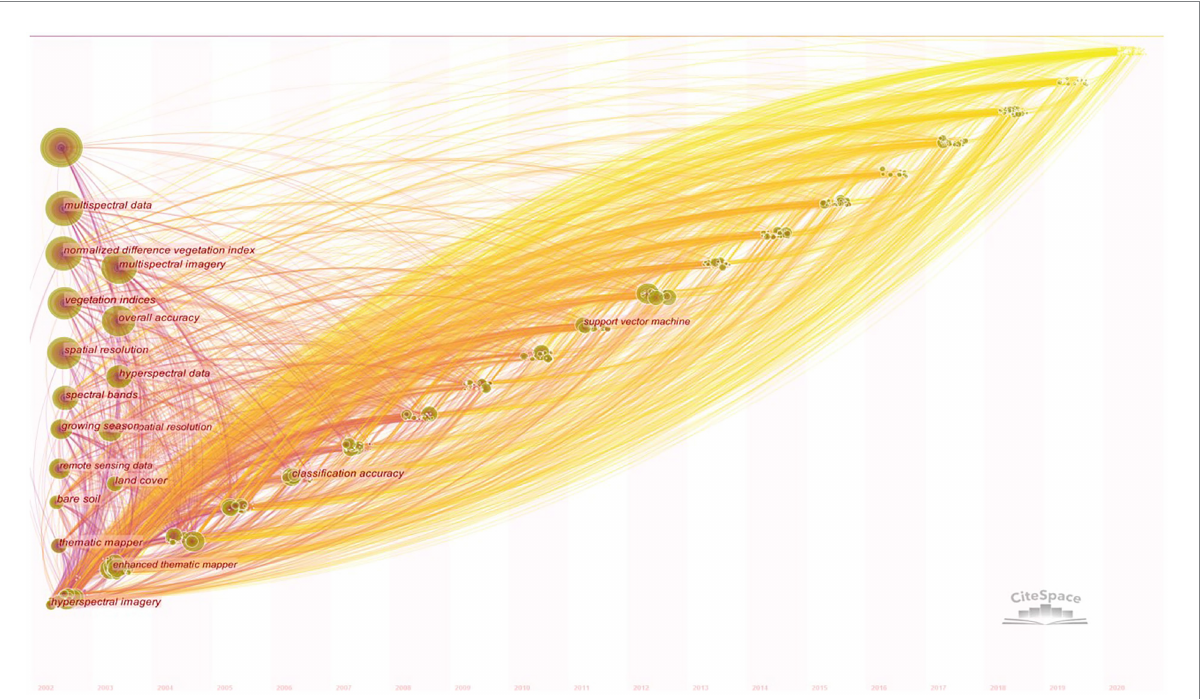
FIGURE 7 Co-occurrence time zone map of theme terms on agricultural multispectral research in 2002–2021. The horizontal axis represents the year, each node represents a topic, and the size of each node represents frequency of occurrence. The lines between each node represent connections to other topics. The circles in the vertical axis represent topics in the multispectral area of agriculture. The size of the circles represents the magnitude of the heat. The years with more topics were arranged in order from the largest to the smallest on the vertical